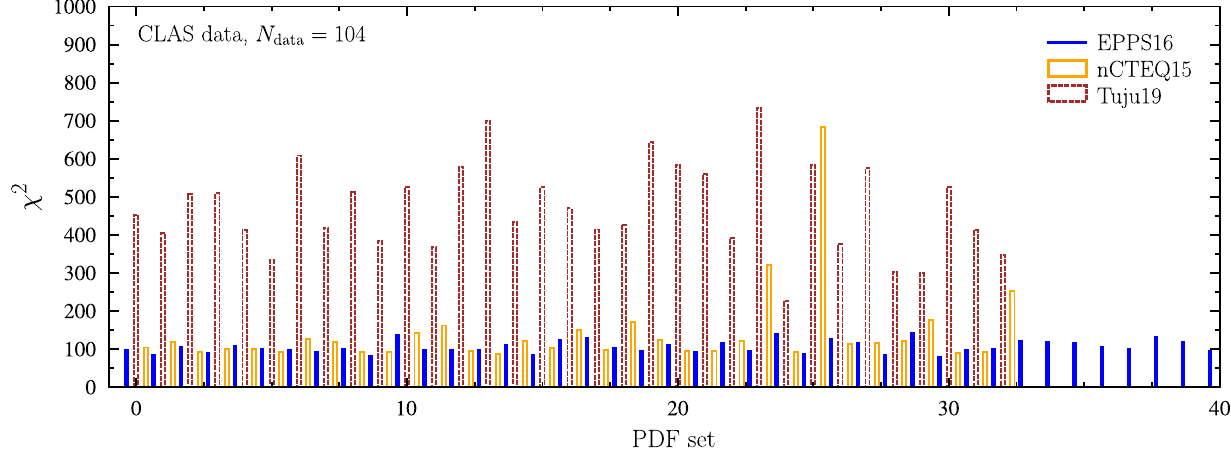
Fig. 3 The χ 2 values corresponding to the central and error sets of the nuclear PDFs